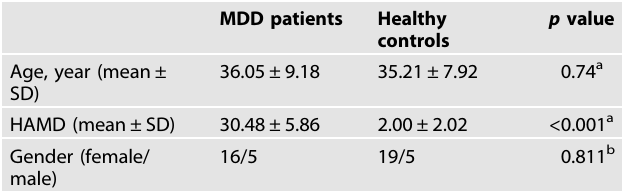
Table 1. Group demographics and clinical